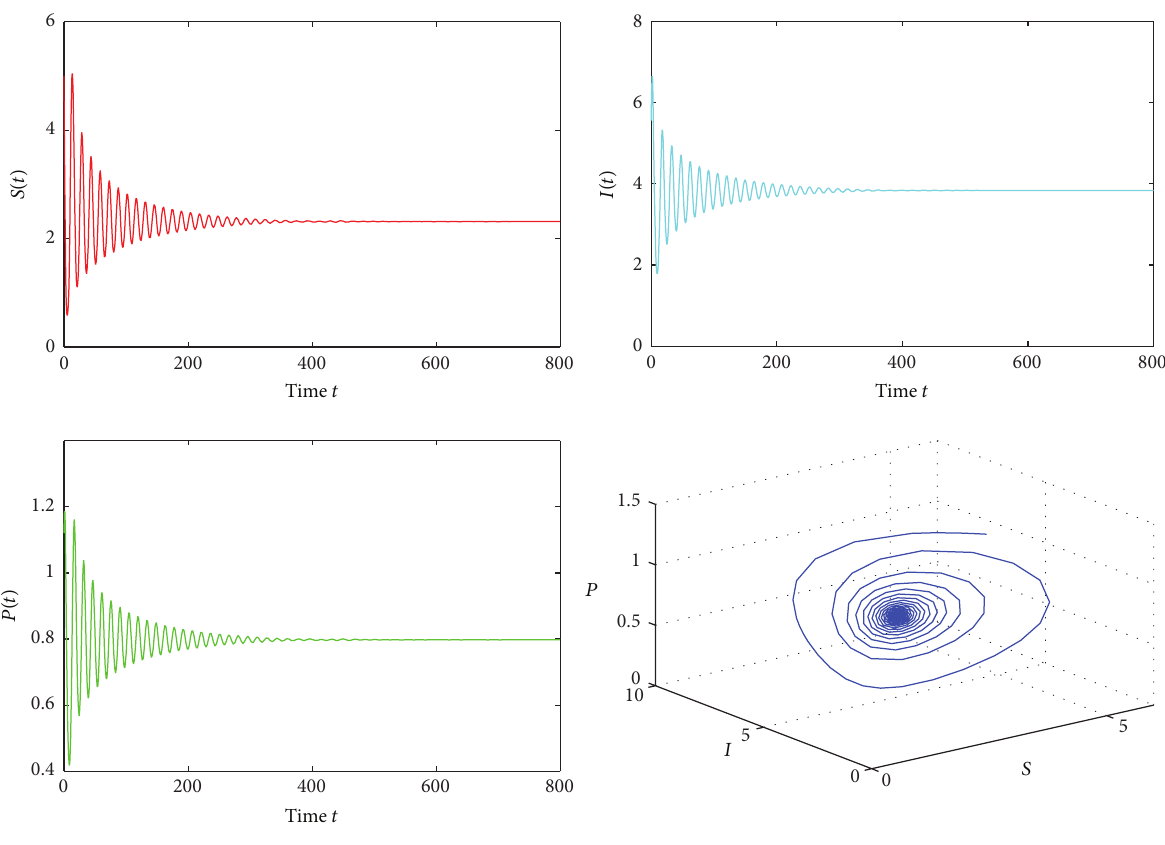
Figure 5: 𝐸 ∗ is asymptotically stable when 𝜏 = 0.25 < 0.3652 = 𝜏 0